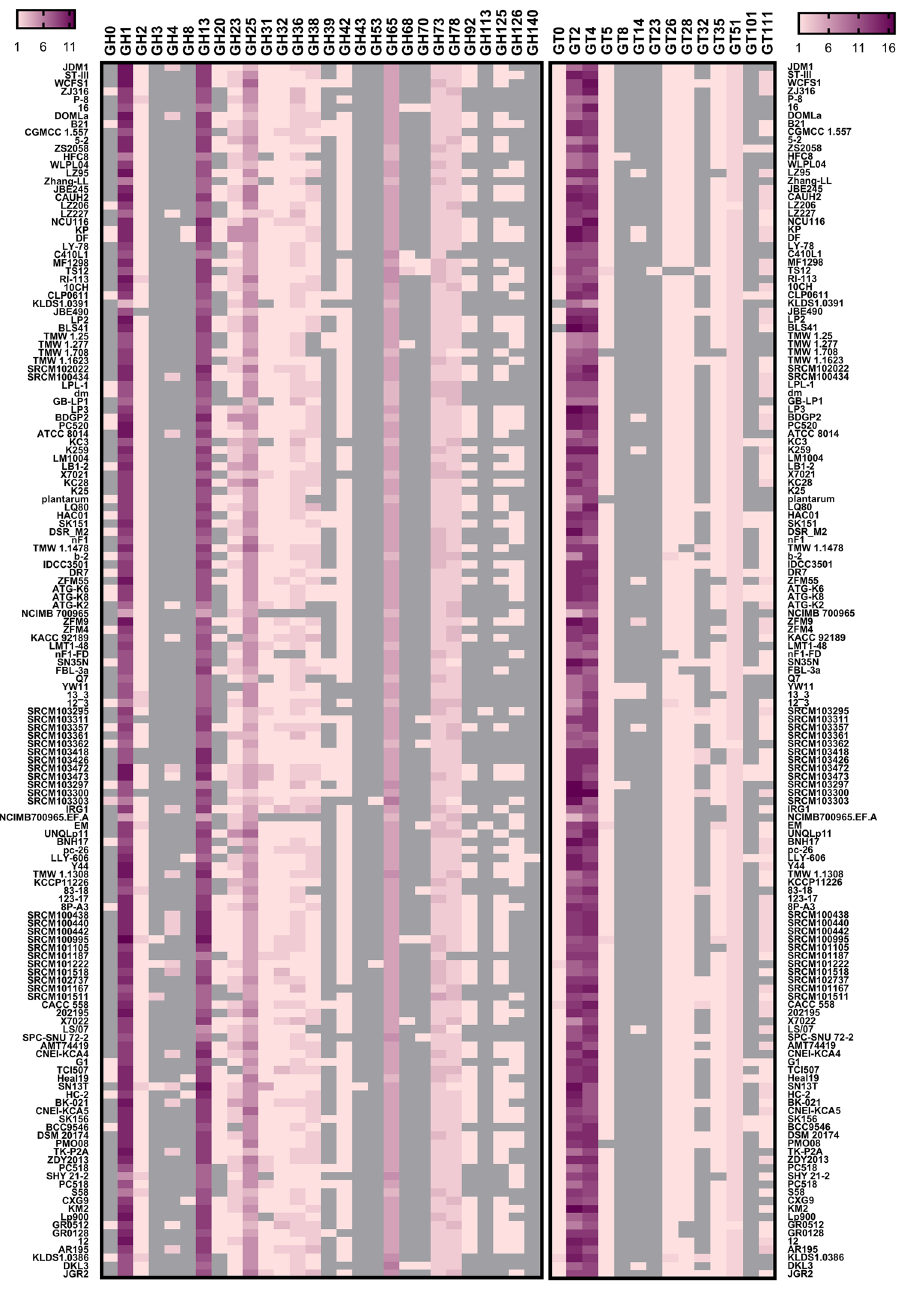
Figure 4. Comparative genomics of L. plantarum strains for the presence of CAZy families. dbCAN2 annotation of the glycosyl hydrolase (GH) and glycosyltransferase (GT) families listed in the CAZy database is depicted as a heatmap. Grey color denotes the absence of that family and pink to dark-purple gradation denotes increasing number of members from that